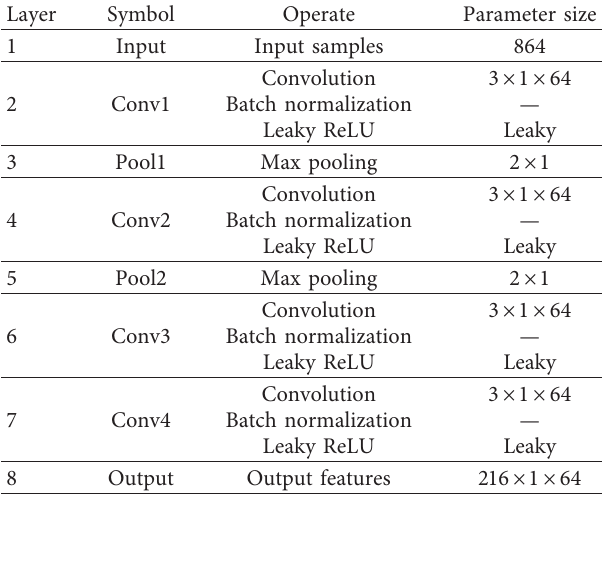
Table 1: Architecture of